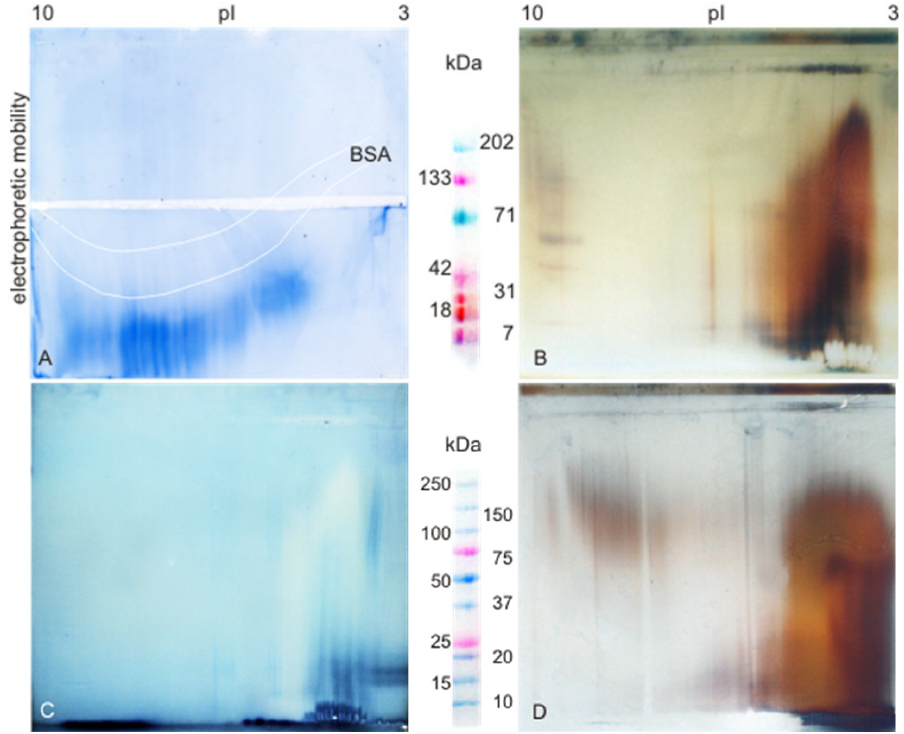
( a ) Titration curve (ETC), showing the acidity of the matrix. Coomassie blue stain; ( b ) Two dimensional gel: conventional fixing procedure, Ag staining; ( c ) Two dimensional gel: conventional fixing procedure, Zn staining for proteins; ( d ) Two dimensional gel: improved fixing procedure, Ag